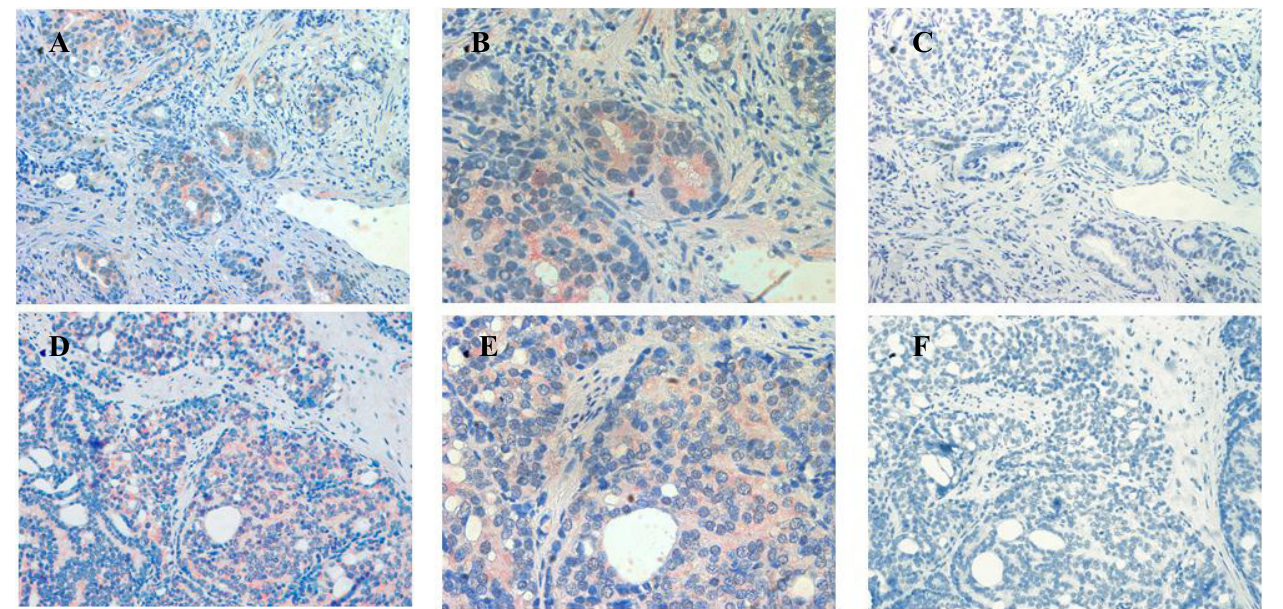
Figure 4. Immunolocalization of ATIP staining in well-differentiated ( A and B ), moderately-differentiated ( D and E ) and poorly-differentiated ( G and H ) prostate cancer in paraffin embedded tissue sections. Serial sections ( C , F and I ) showing little or no staining when the ATIP antibody was pre-absorbed with ATIP antigen. Images were taken at ( A , C , D , F , G and I ) 200× and ( B , E and H ) 400×